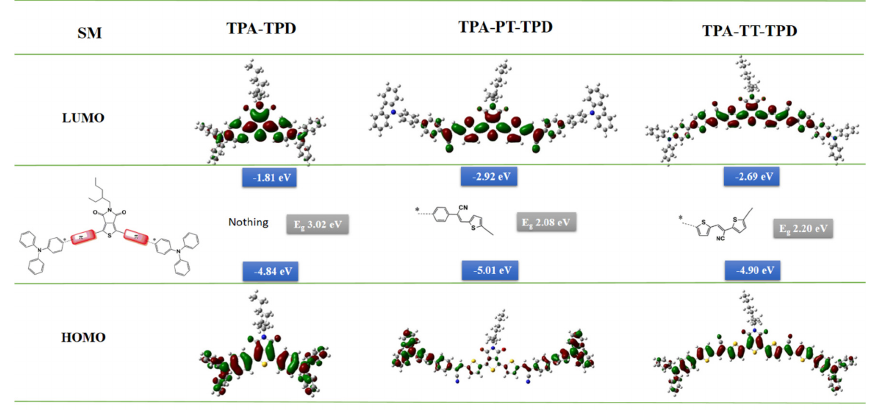
Figure 1. Optimized geometries, electron-state-density distributions and highest occupied molecular orbital-lowest unoccupied molecular orbital (HOMO-LUMO) energy levels of TPA-TPD , TPA-PT-TPD and TPA-TT-TPD using density functional theory (DFT) at the B3LYP/6-31G (d) level.